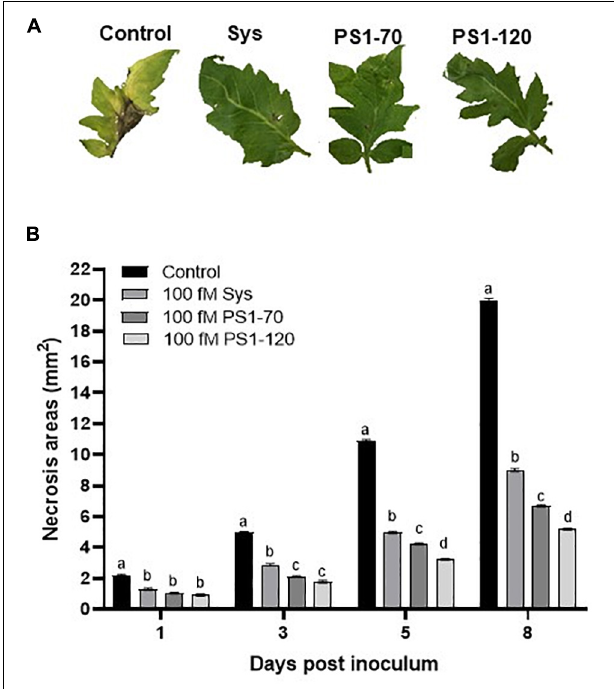
FIGURE 4 | Enhanced resistance to B. cinerea by plants treated with ProSys fragments and Sys peptide. Response to B. cinerea infection in leaves from mock-treated (Control) and Sys, PS1-70 and PS1-120 treated plants. (A) Pictures show necrosis symptoms on detached tomato leaves 8 days after fungus inoculation. (B) The graphs display the mean of the lesion size at 1, 3, 5, and 8 days post-inoculum. Letters indicate different statistical groups (One-Way ANOVA, P < 0.05). Error bars indicate standard